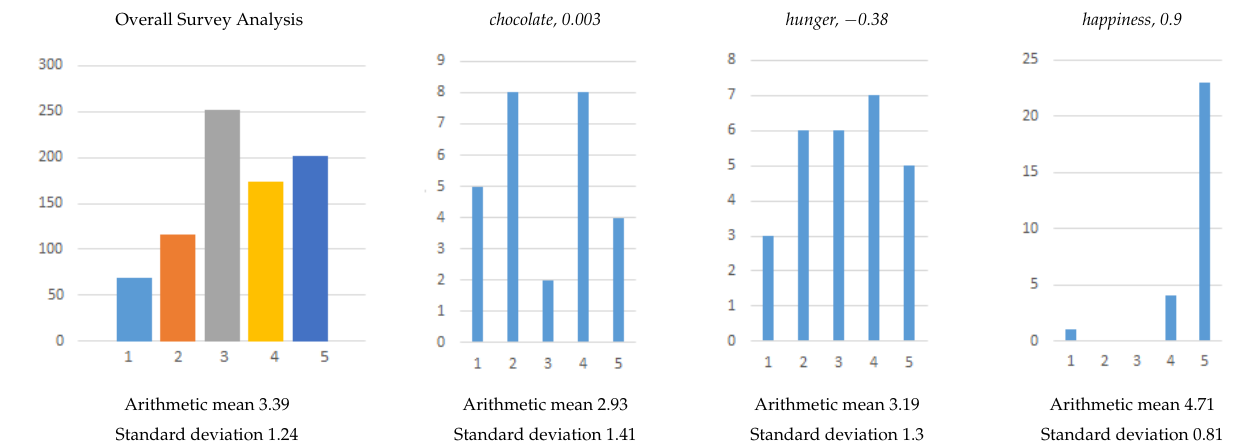
Figure 7. Survey Analysis on SenticNet 6 polarity-value ODV